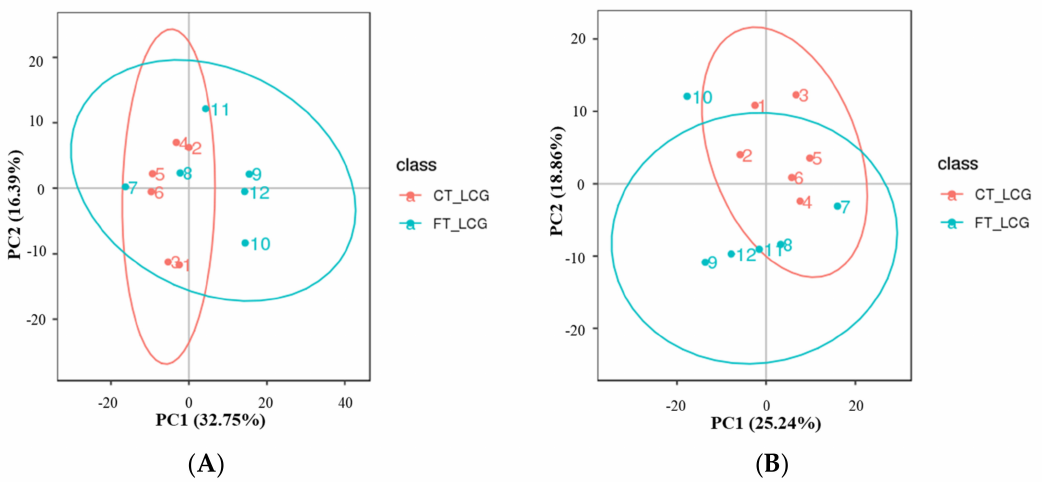
Figure 2. Total sample PCA plot (( A ): positive mode; ( B ): negative mode). The fractions of the first and second main components are shown in the figure as the abscissa PC1 and ordinate PC2, respectively. The ellipse in the diagram represents the 95 percent confidence interval, and the scattered spots in the figure indicate of experimental samples.